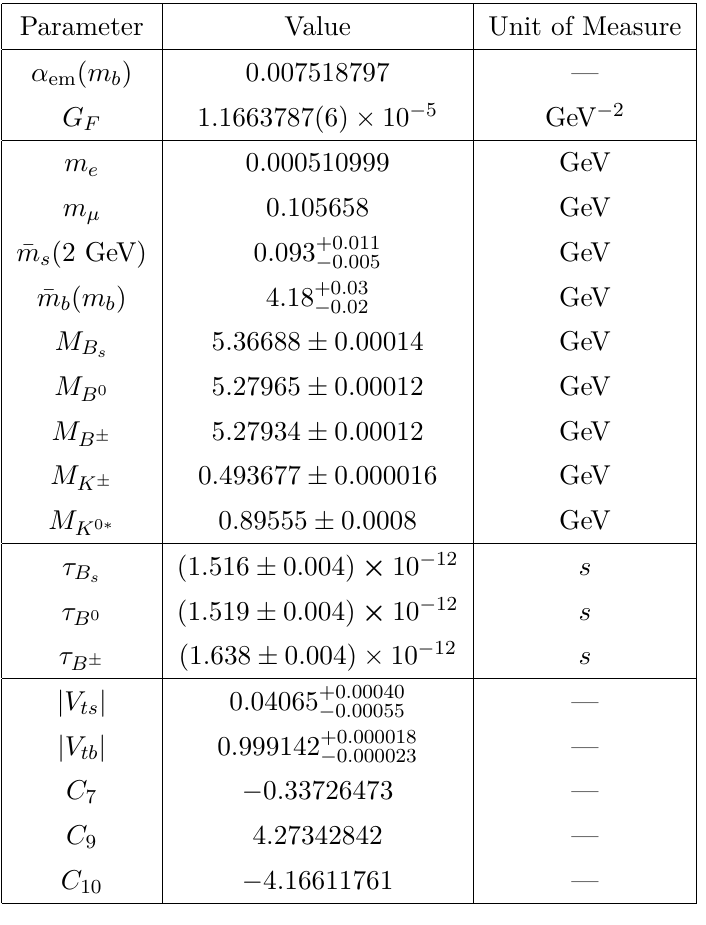
Table 3. Parameters used for the computations. The quark masses are estimates of the MS scheme at the given renormalisation scale [117]. The values of the WET Wilson coefficients are those used in EOS